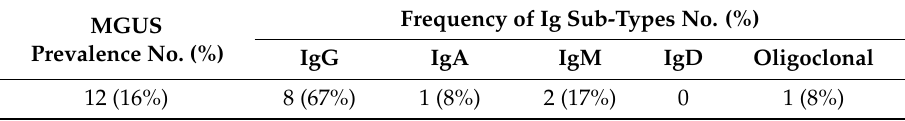
Table 4. The MGUS (monoclonal gammopathy of undetermined significance) Prevalence and Frequency of Ig